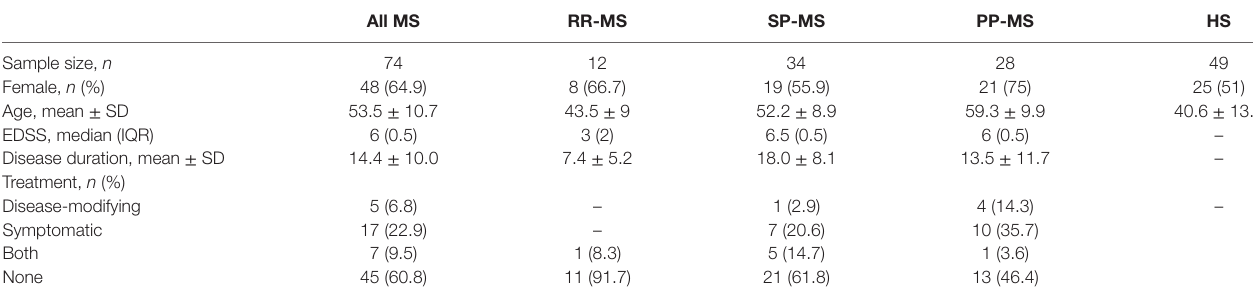
TaBle 1 | Demographic and clinical